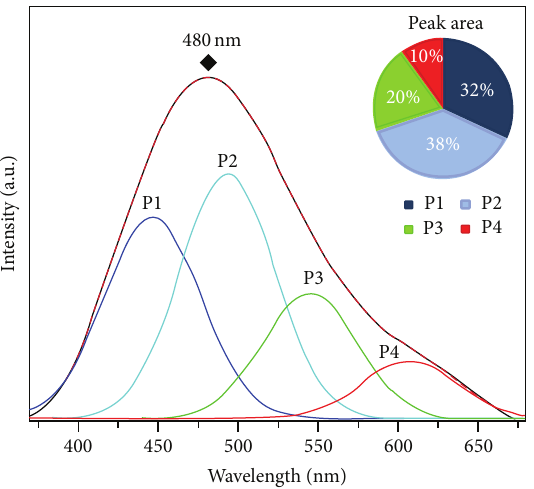
Figure 5: PL spectrum at room temperature and its deconvolution spectra of the 𝛼 , 𝛽 -NiMoO 4